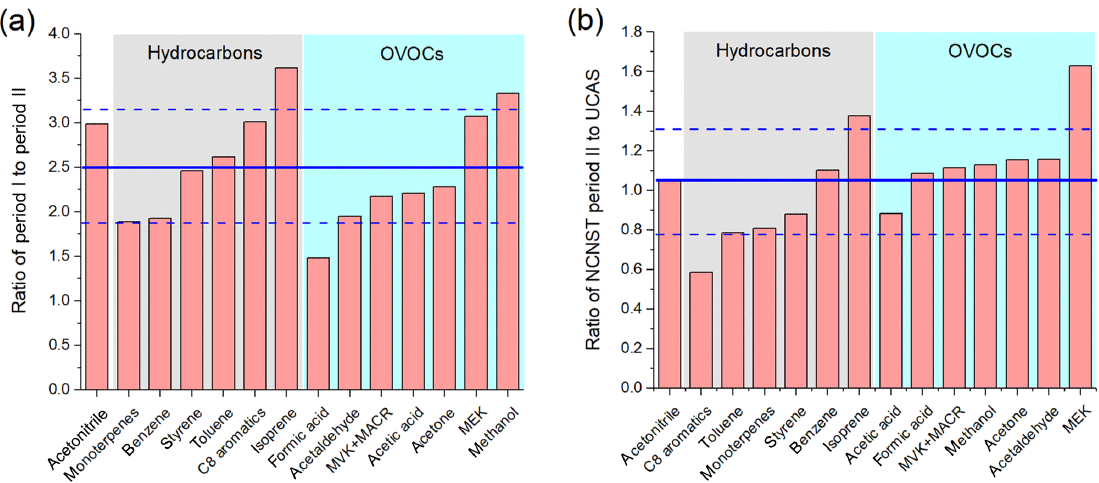
Figure 9. Ratio of (a) concentrations of urban period I to concentrations of urban period II; (b) concentrations of urban period II to concen- trations of the suburban site. Blue lines are average value of the ratios and standard deviations.